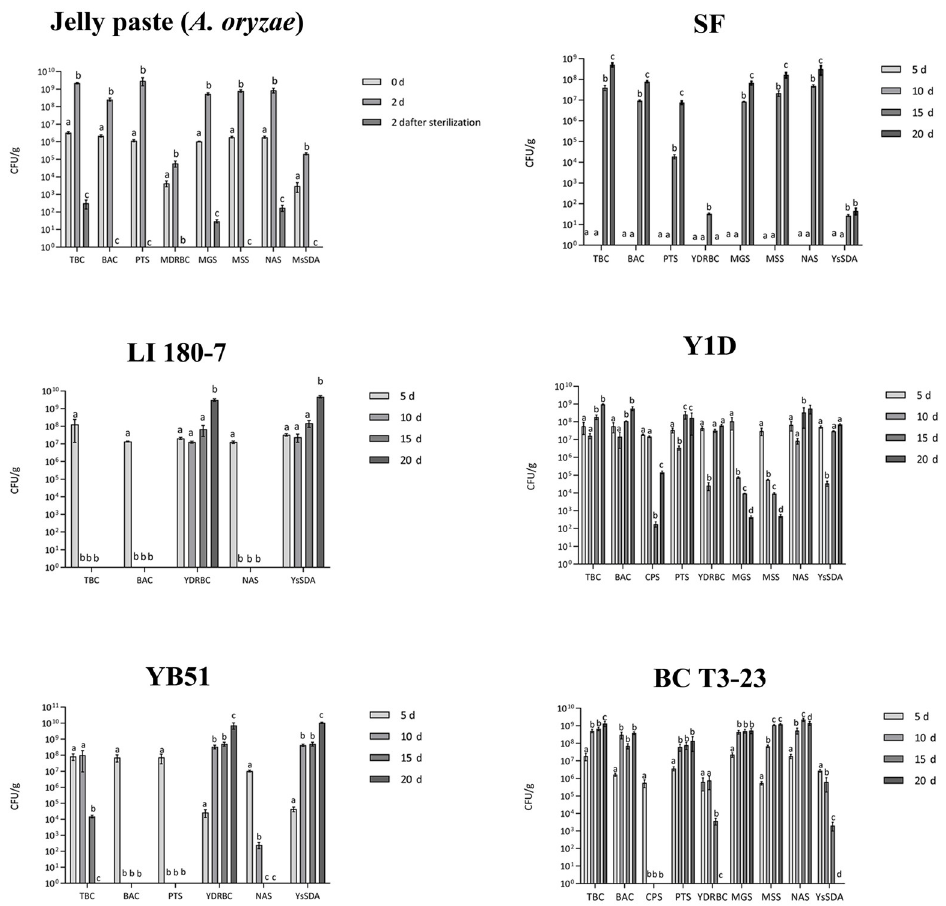
Figure 2. Evolution of microbial counts over 20 days of fermentation of Jellyfish-based food products inoculated with selected yeast strains. Jelly paste ( Aspergillus oryzae ): product obtained by the first fermentation step (solid-state fermentation) performed by inoculating the Koji starter ( A. oryzae ) into Jellyfish puree (consisting of jellyfish, starch and wheat bran). SF: spontaneous fermentation of uninoculated Jelly paste, as control. Y1D: Metschnikowia sp., YB51: Candida parapsilosis ; BC T3-23: Debaryomyces hansenii ; LI 180-7: Saccharomyces cerevisiae . The initial inoculum of the four yeast starter strains (LI 180-7, YB51, BC T3-23, Y1D) was about 10 7 CFU/g. Microbial parameters: TBC (total bacterial count, accounting for aerobic colony count), BAC ( Bacillus spp.), CPS (presumptive coagulase-positive staphylococci), PTS (presumptive total staphylococci), YDRBC (total yeast count), MDRBC (total mold count), MGS (MRS glucose seawater salts), MSS (MRS sucrose seawater salts), NAS (nutrient agar seawater salts). Media where microbial counts were equal to zero were not reported. For each fermented sample, microbial parameters were individually submitted to one-way analysis of variance (ANOVA), and Tukey’s post hoc method was applied to determine significant differences ( p < 0.05) among the microbial counts at different time points (as showed in the graph legends).